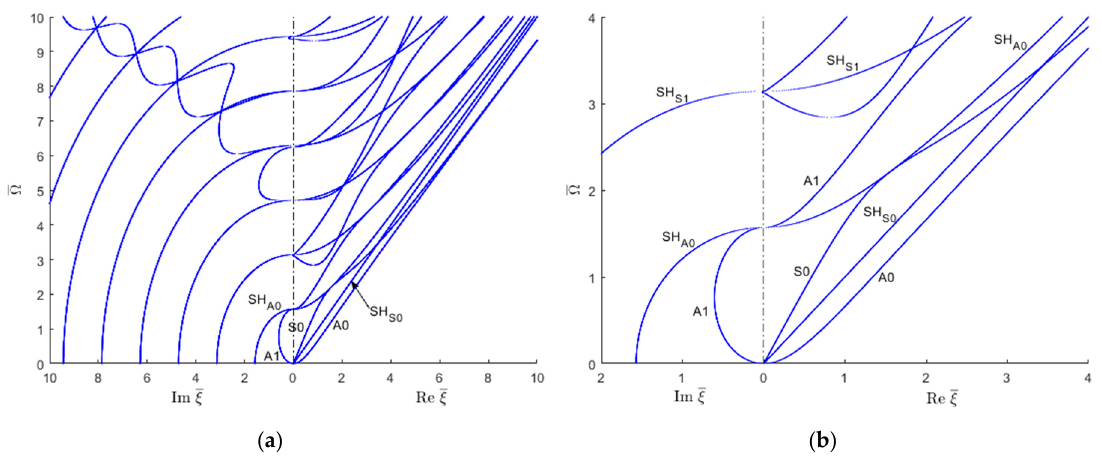
Figure 8. Real and imaginary wavenumber roots for an isotropic aluminum alloy plate using the SAFE method: ( a ) overall plot; ( b ) zoom in near the origin.